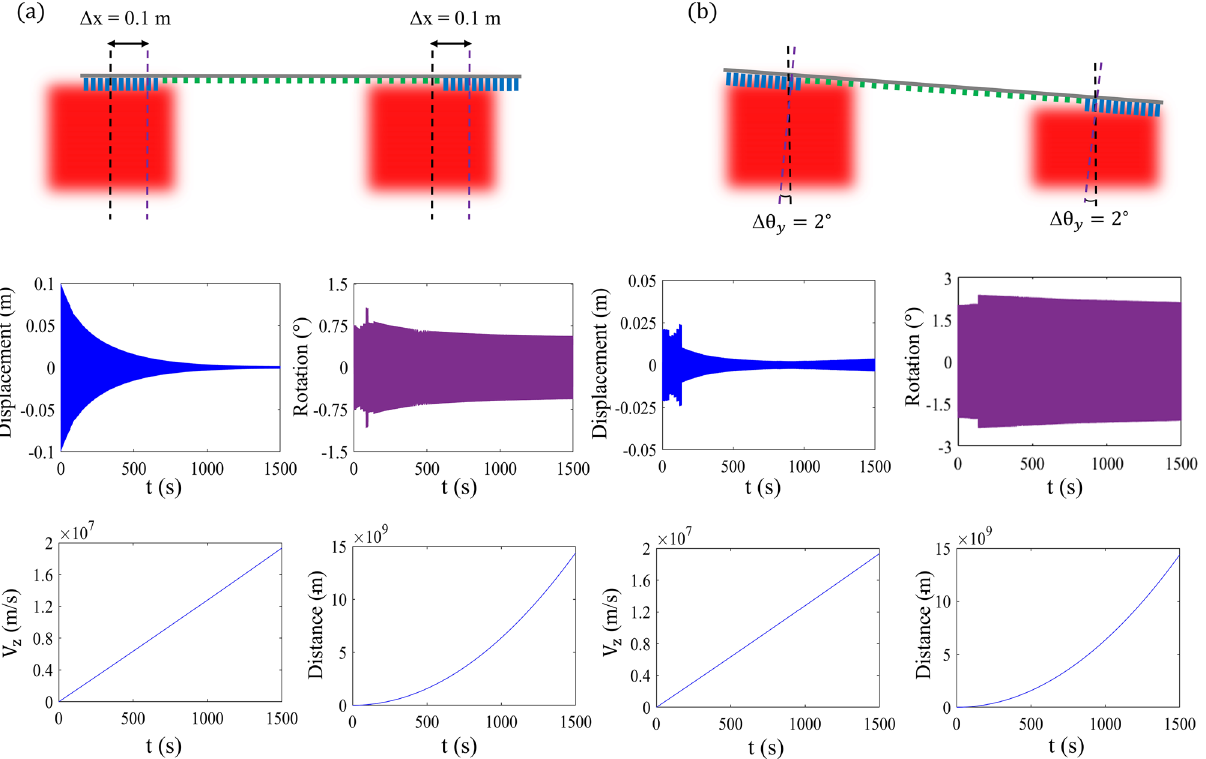
2 m 2 dual-pattern × 10 cm with respect to the incident multi- = 2 ◦ with respect to =